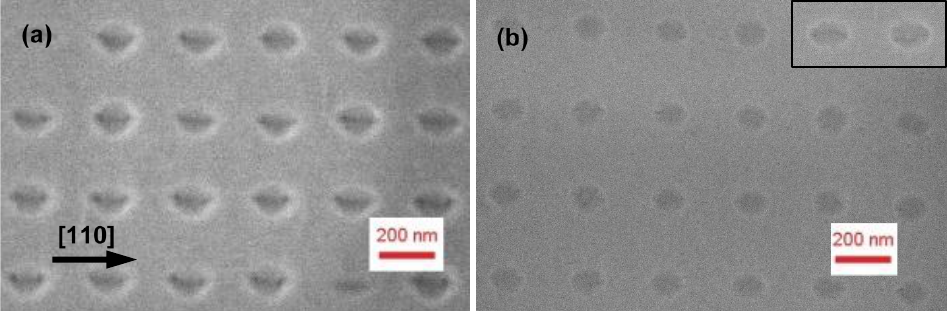
Figure 5. SEM images of 10nm GaAs deposited on a Ga- ( a ) and In-deoxidized ( b ) patterned GaAs surface. Inset in (b) shows two holes of an IAD pattern annealed for longer times (10 min) after In